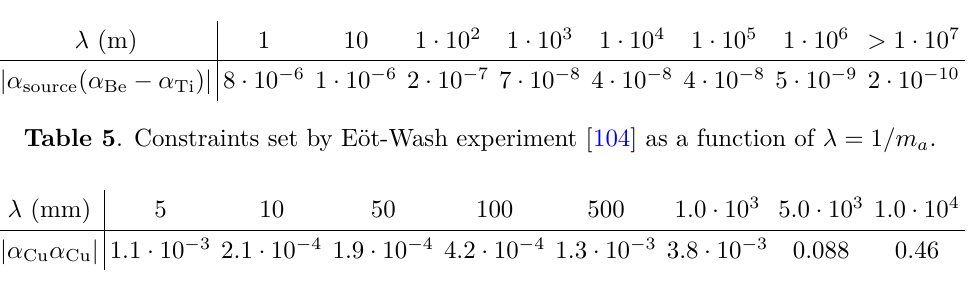
Table 6 . 95% C.L. constraints on the combinations | α Cu α Cu | as a function of λ = 1 /m a set by the Irvine measurements